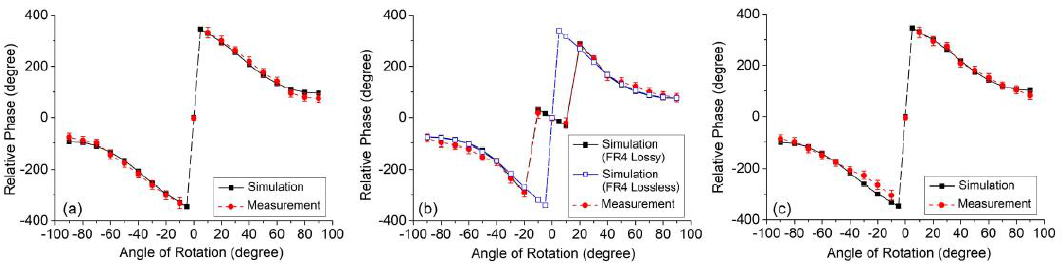
Figure 17. Differential phase of the reflection coefficients seen from the ports for the sensor of Figure 16, for ( a ) rotor A, ( b ) rotor B, and ( c ) rotor C. Reprinted with permission from [65].